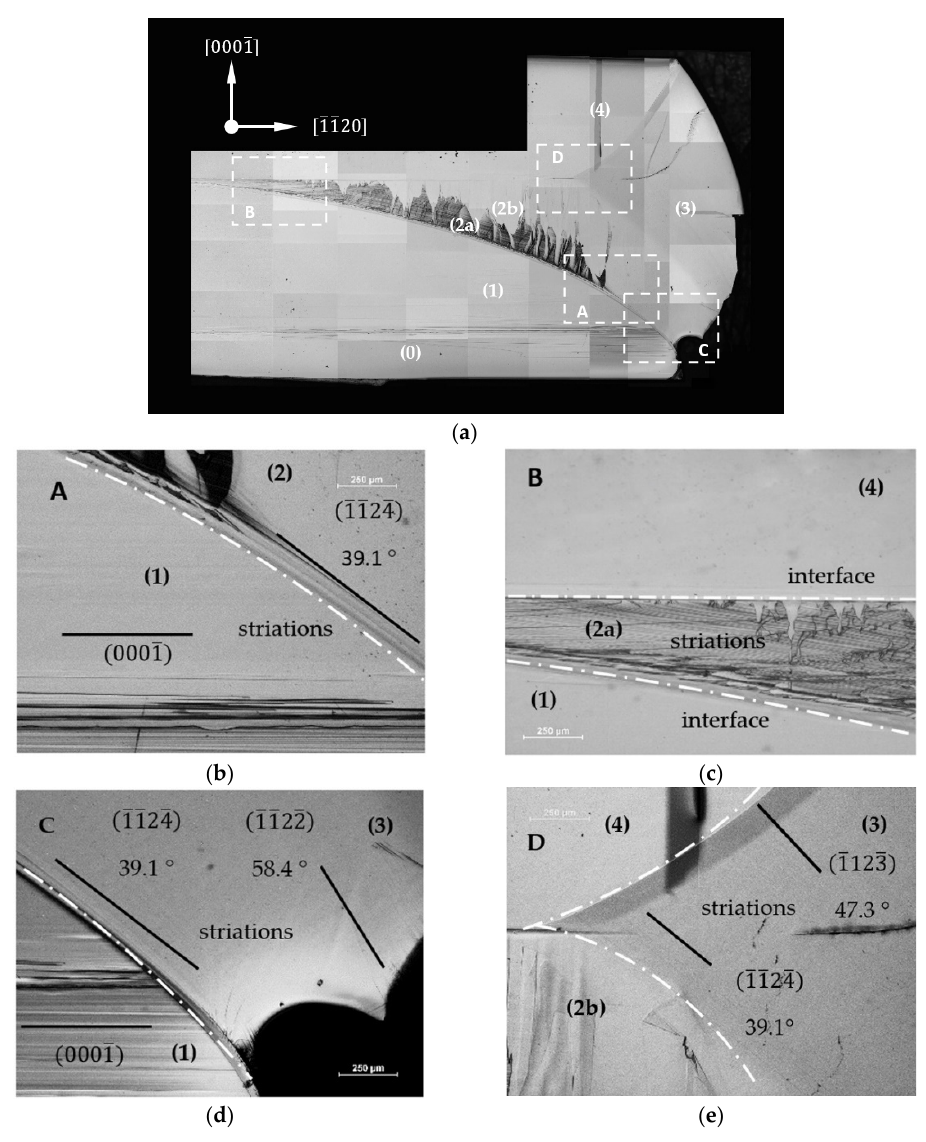
Figure 5. Images of the (1(cid:3364)1(cid:3364)00) slice of an Am-GaN crystal after the PE: ( a ) View of the entire sample; white rectangles (A–D) indicate sectors for further detailed analysis. ( b ) Sector A; ( c ) sector B; ( d ) sector C; ( e ) sector D. Crystallographic planes parallel to the visible striations and their angle of inclination to the (0001(cid:3364)) plane are marked: the (1(cid:3364)1(cid:3364)24(cid:3364)) plane and 39.1°, the (1(cid:3364)1(cid:3364)22(cid:3364)) plane and 58.4°, and the (1(cid:3364)1(cid:3364)23(cid:3364)) plane and 47.3°; the interfaces between different areas of the crystal (see Figure 3a) are marked with white dashed lines.